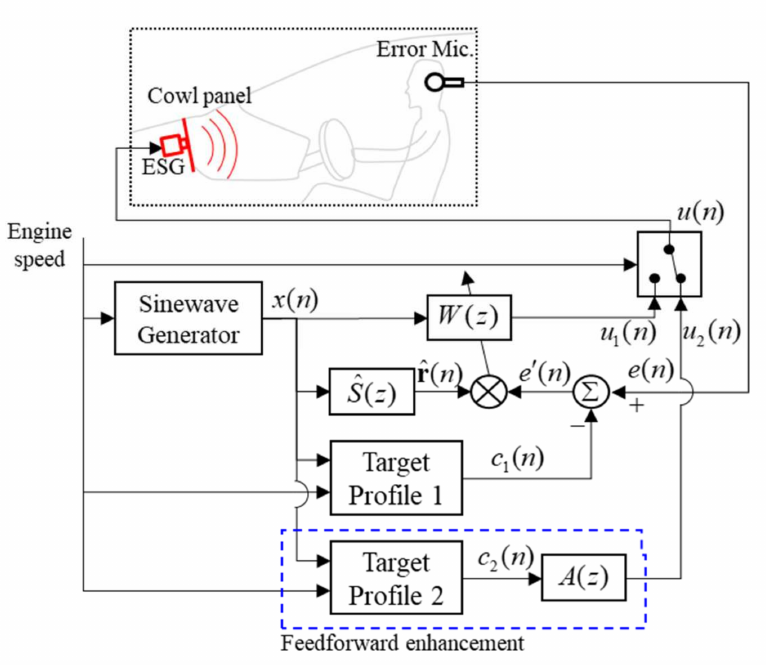
Figure 3. Block diagram of the proposed additive ASP control algorithm with the feedforward en-